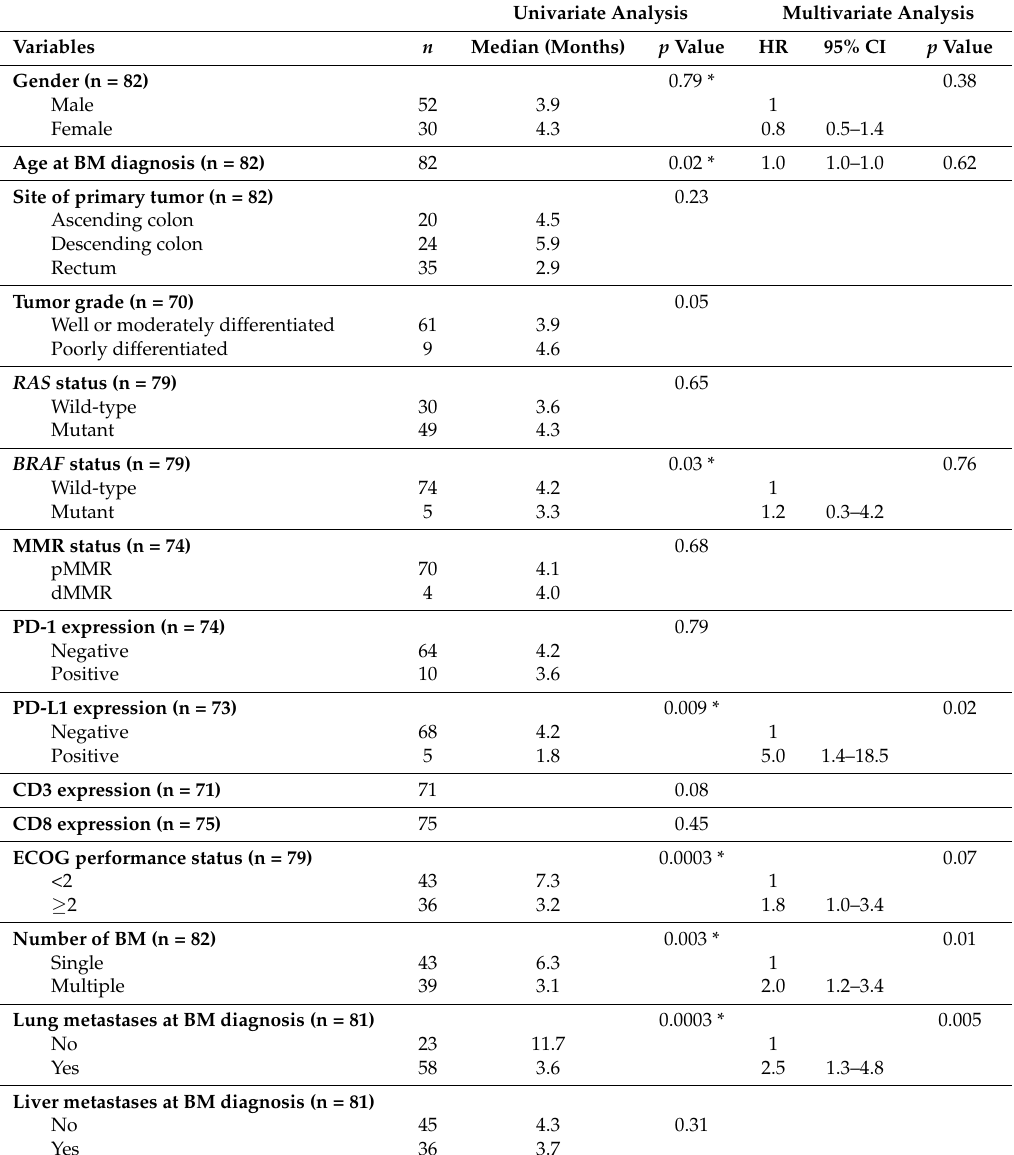
Table 4. Univariate and multivariate analysis of overall survival in patients with brain metastases from colorectal